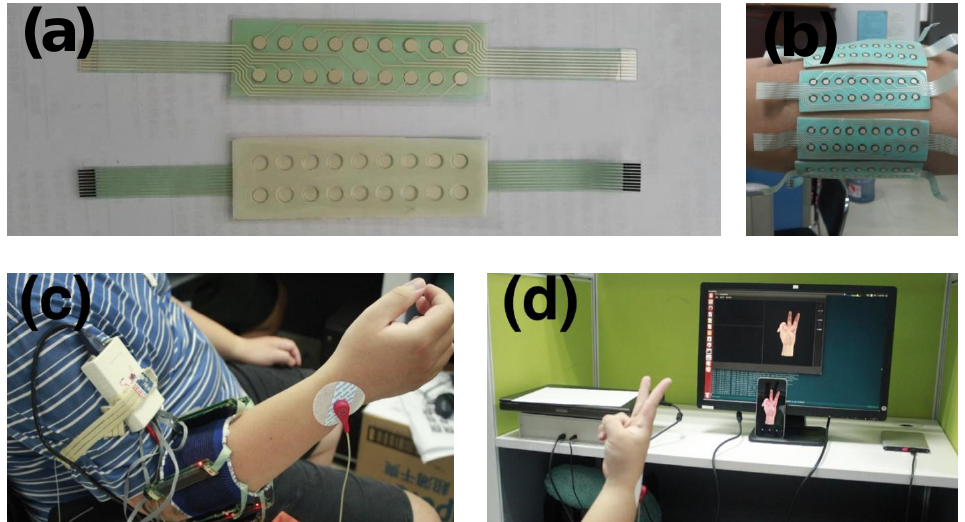
Figure 9. The acquisition setting-up for CapyMyo dataset [111]: ( a ) The EMG electrode array; ( b ) 8 EMG electrode arrays on the right forearm; ( c ) The EMG acquisition device ready for capture; ( d ) The software subsystem to present the guided hand gesture and record EMG data